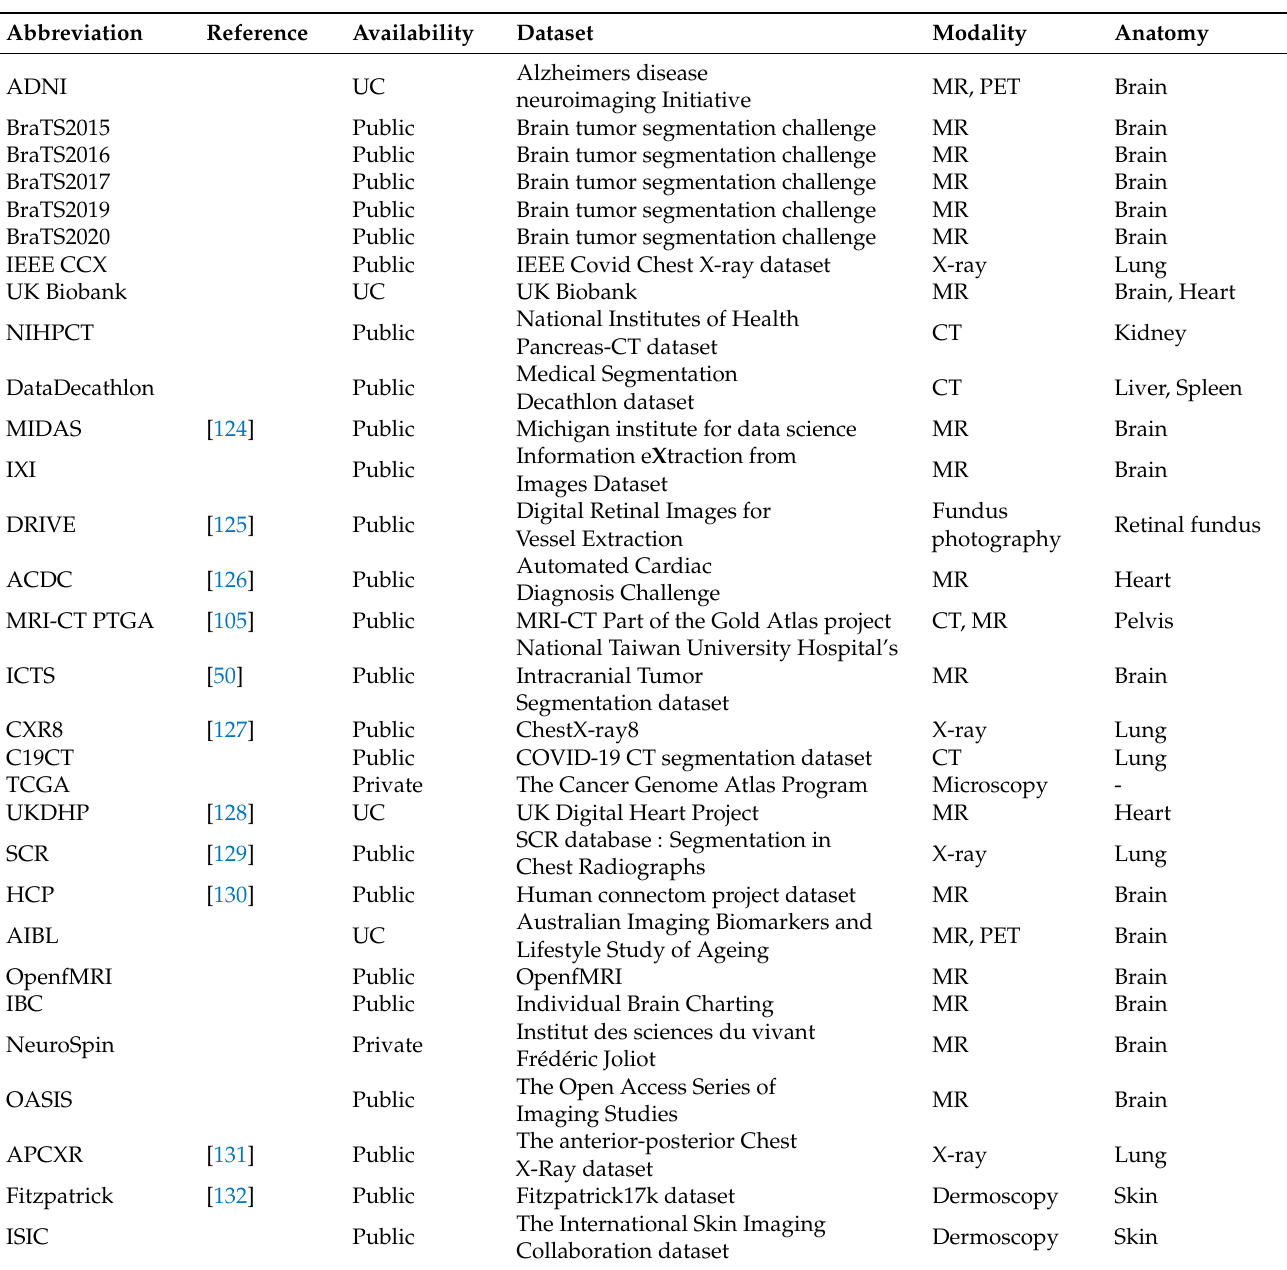
Table 4. Summary of the datasets utilized in various publications of deep generative models, or- ganized by modality and body part. For each dataset, the corresponding availability is indicated as public, private, or under certain conditions (UC). Additionally, if a public link for the dataset is available, it is